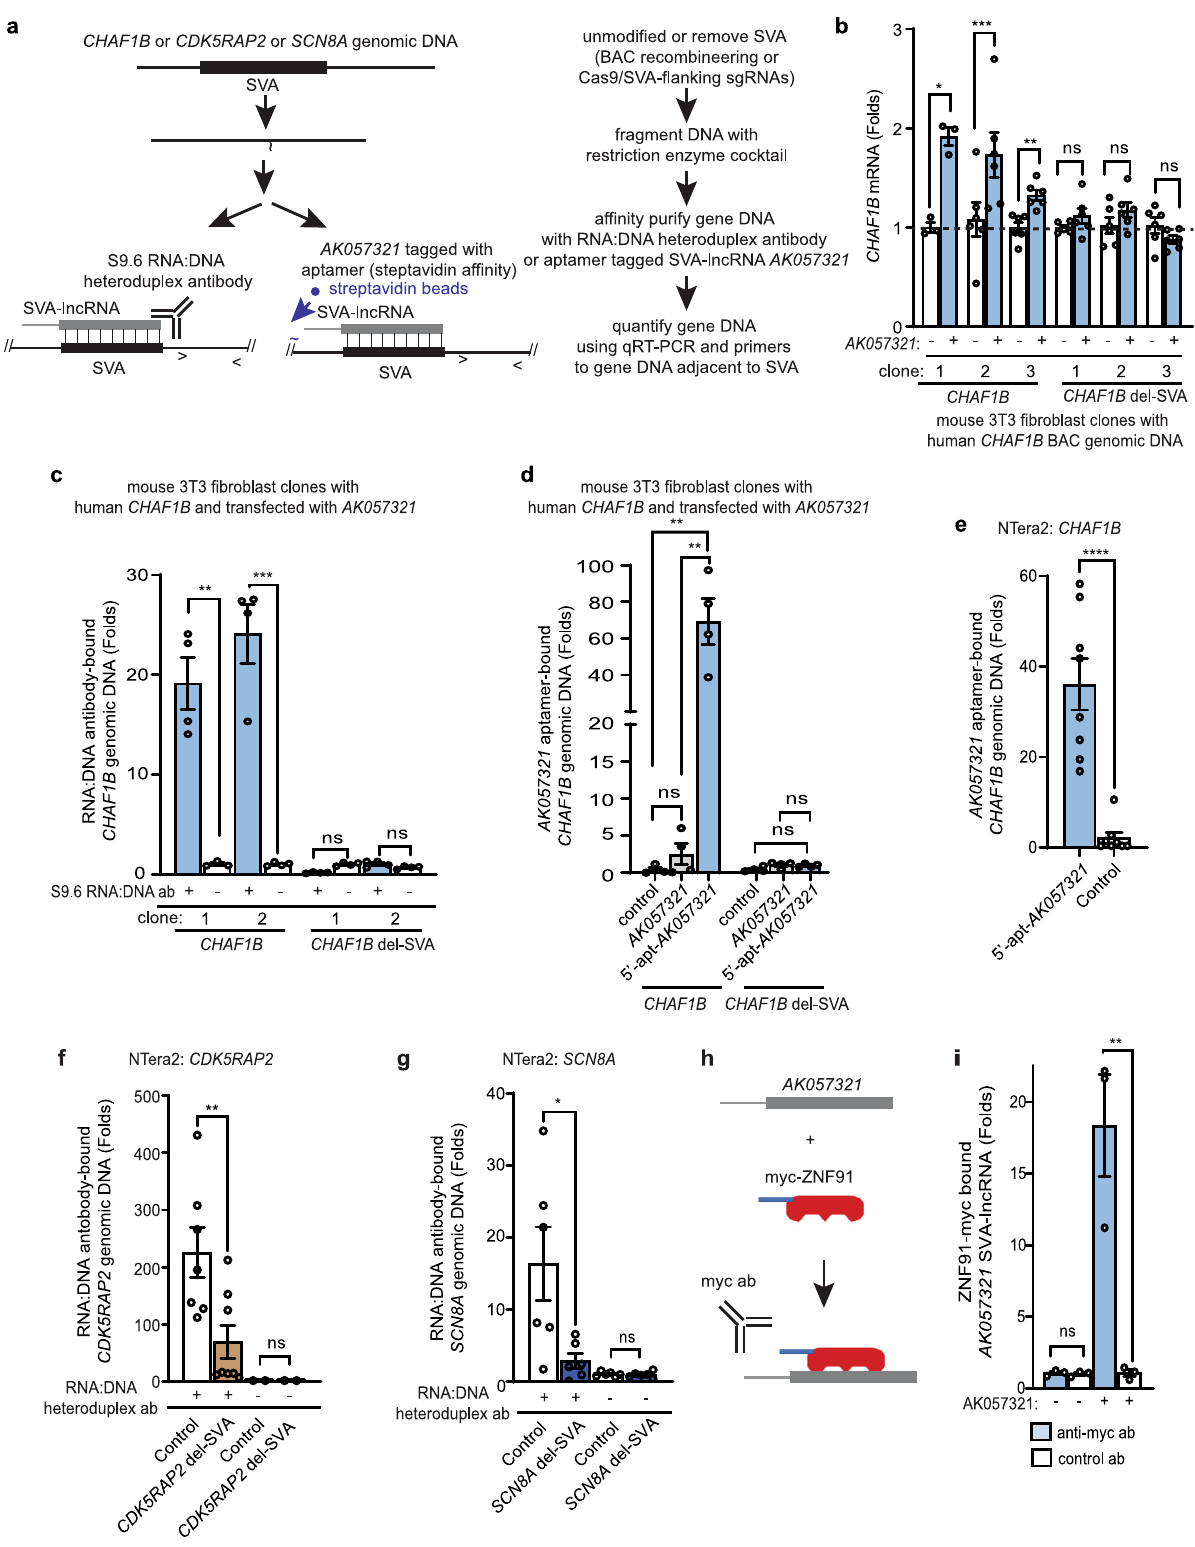
To provide evidence that SVA-lncRNA AK057321